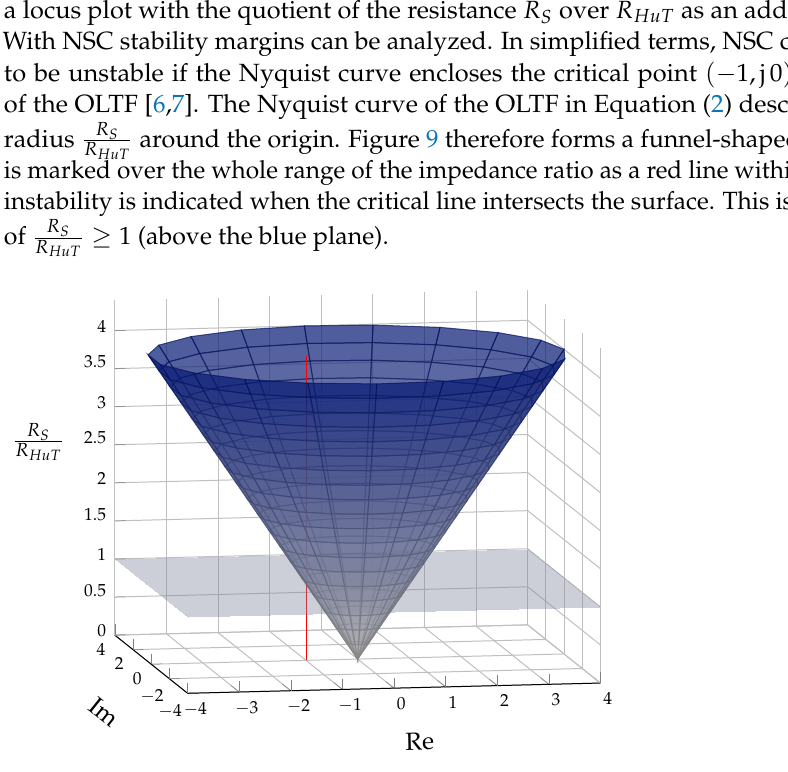
Figure 9. Nyquist curve for resistive impedance PHiL in dependence of the quotient of resistance R S over R HuT